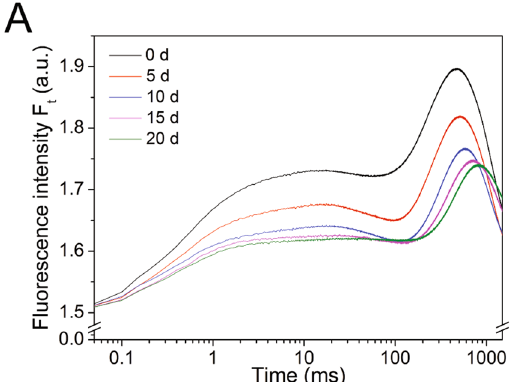
Figure 4. OJIP fluorescence transients of nitrogen-starved P. cruentum plotted on a logarithmic time scale.